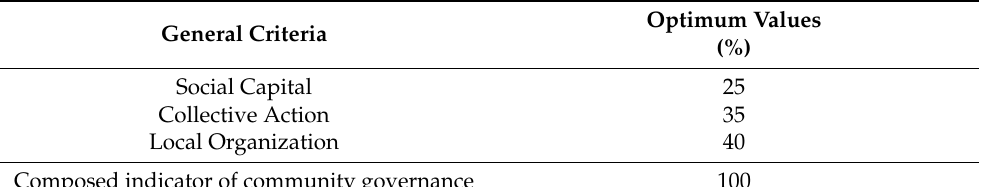
Table 1. General criteria and optimum values of the composed indicator of community forest governance.